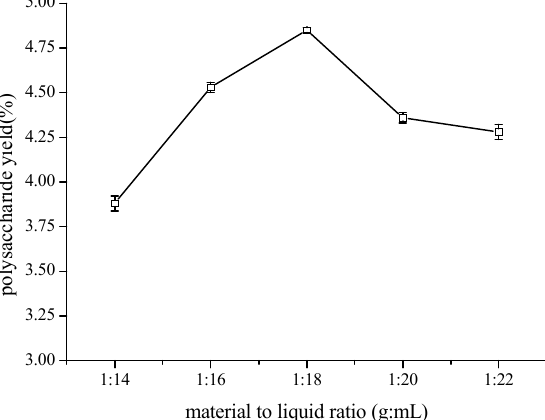
Figure 4. Effect of different material to liquid ratios on the polysaccharide yield (w/w dry crushed material %) from TCBL.